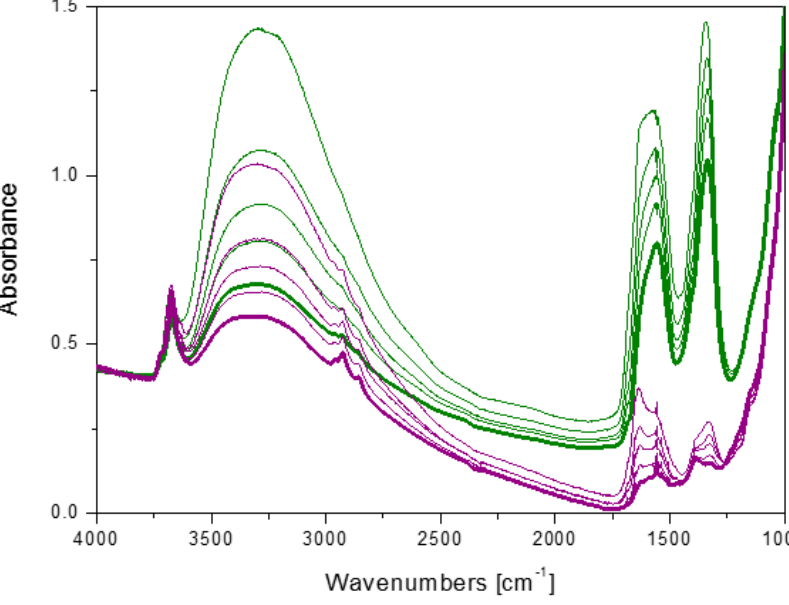
Figure 10. Comparison among the normalised FTIR absorbance spectra of CuO-TiO 2 (green curves) and Au-TiO 2 (violet curves) reported in Figure 8. Spectra normalised to the pellet density.